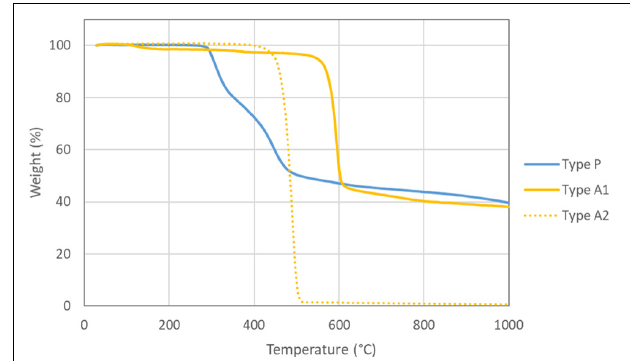
FIGURE 2 | Weight loss of fibers versus temperature during TGA heating ramps. Type P (polyacrylonitrile fiber) and type A (aramid and polyolefins fibers).